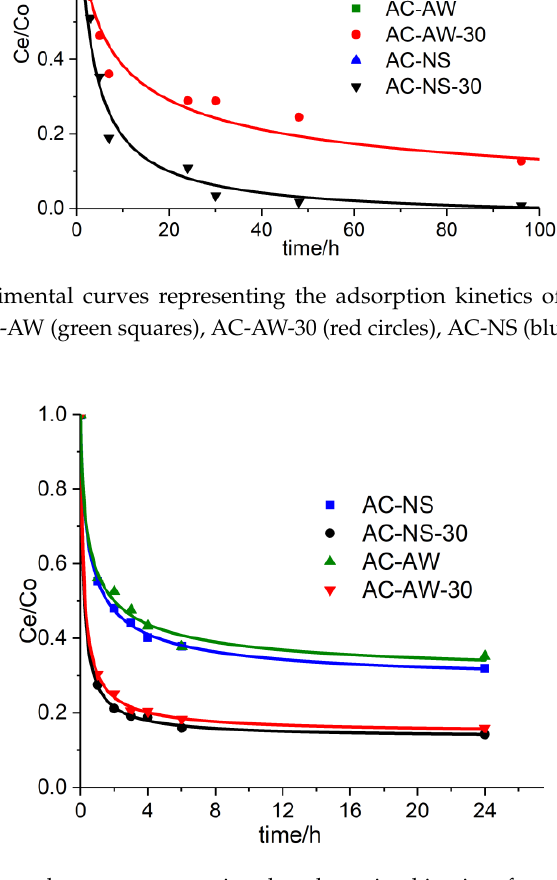
Figure 3. The experimental curves representing the adsorption kinetics of vitamin B 12 into the activated carbons: AC-AW (green squares), AC-AW-30 (red circles), AC-NS (blue triangles), AC-NS-30 (black triangles).